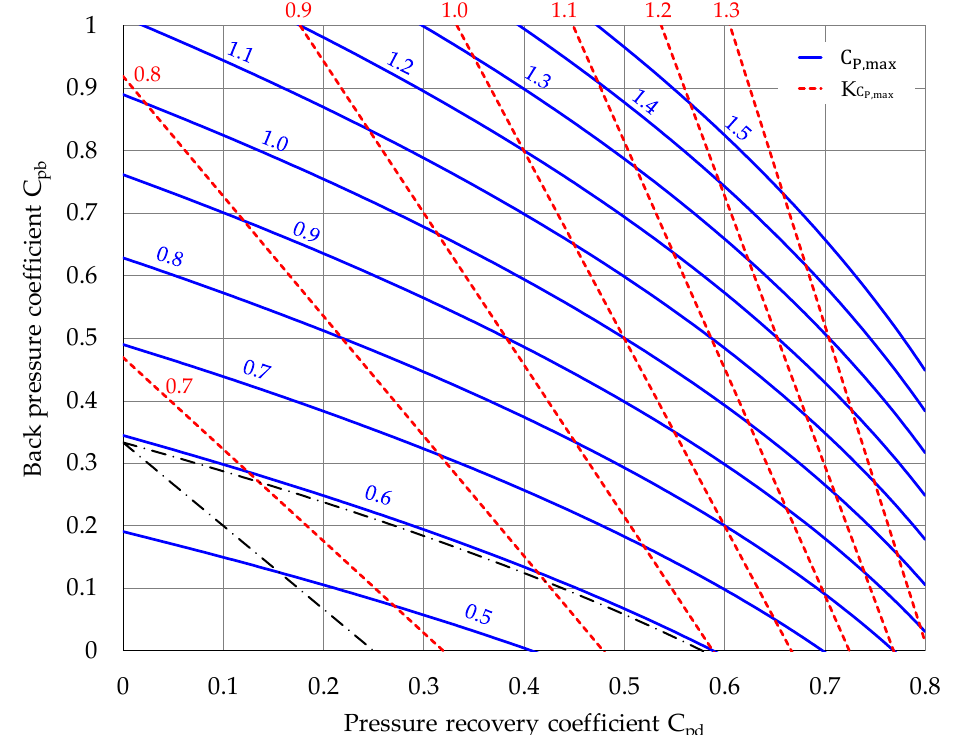
Figure 8. Maximum input power coefficient and inlet velocity ratio for a given combination of diffuser pressure-recovery coefficient and brim back pressure coefficient.